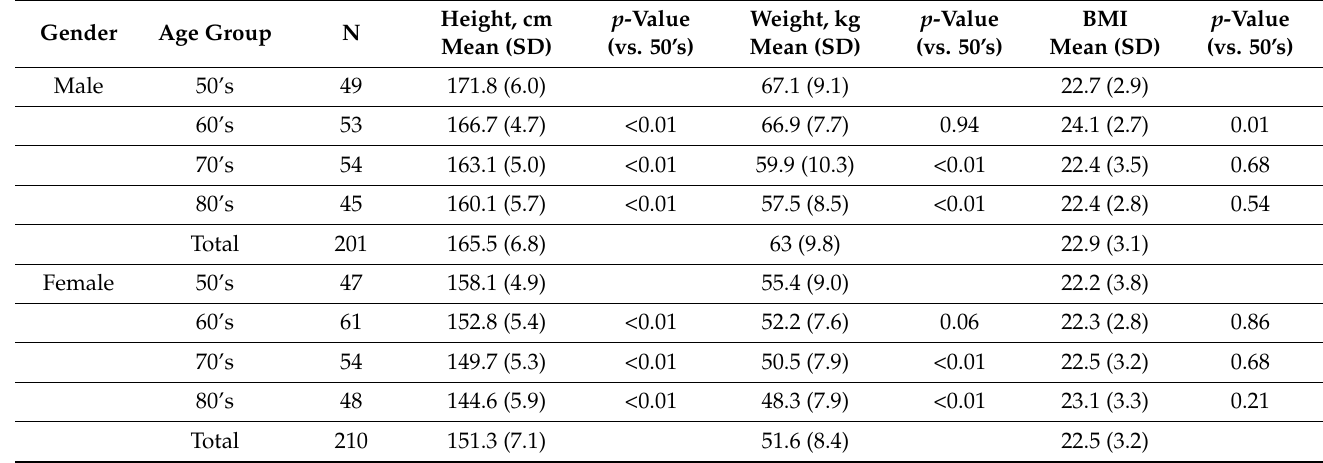
Table 1. Baseline characteristics.